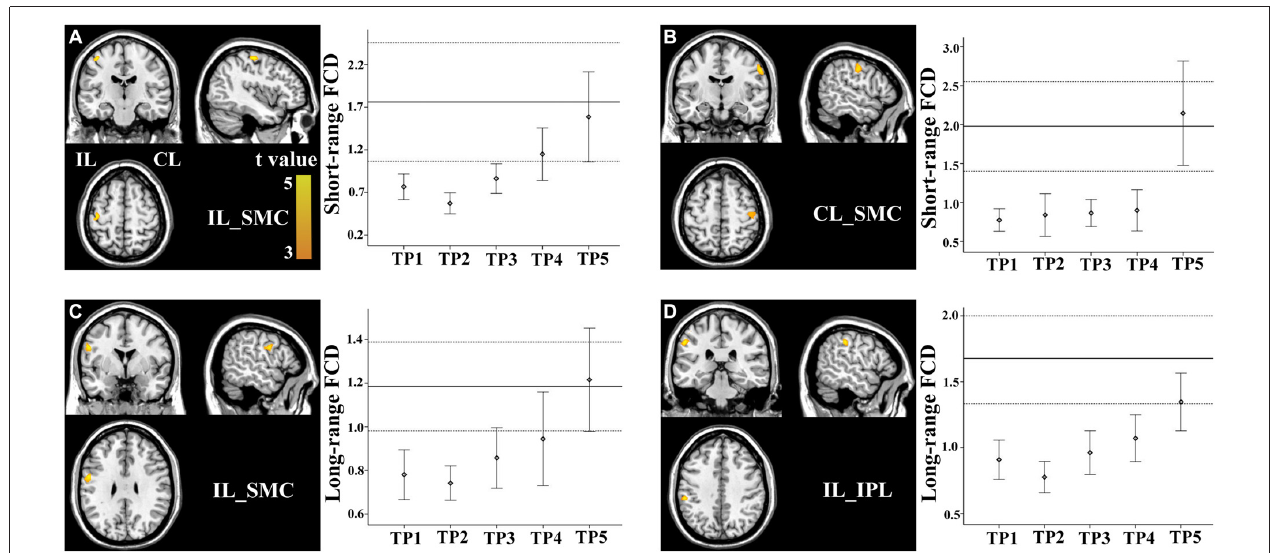
FIGURE 3 | Linear changes in functional connectivity density (FCD) in the sensorimotor regions in stroke patients . The ipsilesional (A) and contralesional (B) SMCs exhibit linearly increased short-range FCD. The ipsilesional SMC (C) and inferior parietal lobule (IPL) (D) exhibit linear increases in long-range FCD. The solid and dashed lines demonstrate the mean and standard error of the FCD in normal controls, respectively. Error bars illustrate the standard error. CL, contralesional; FCD, functional connectivity density; IL, ipsilesional; SMC, sensorimotor cortex; TP, time points.